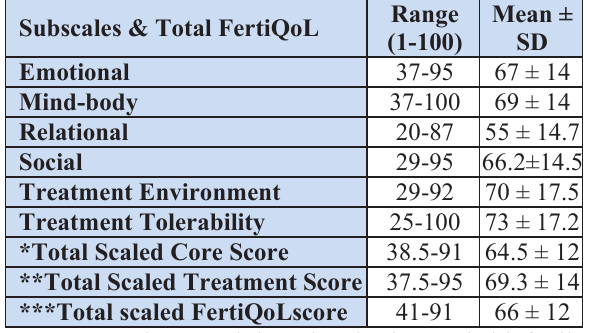
Table-2: FertiQoL and the subscales in married infertile